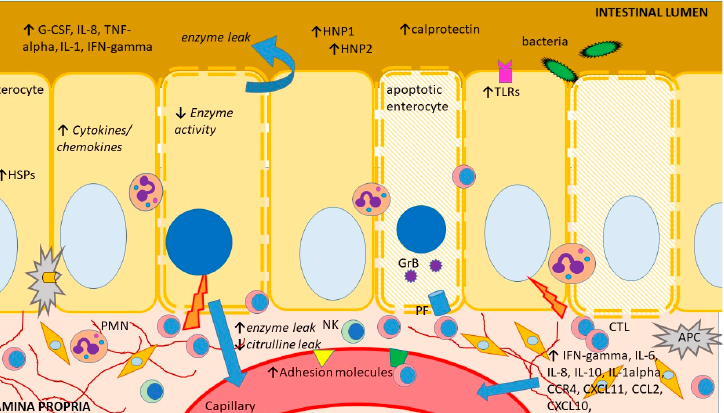
Figure 2. Schematic representation of the main sites and mechanisms of injury during intestinal acute rejection as well as an outline of its main consequences and features previously explored as biomarkers. APC—antigen-presenting cell, G-CSF—granulocyte colony-stimulating